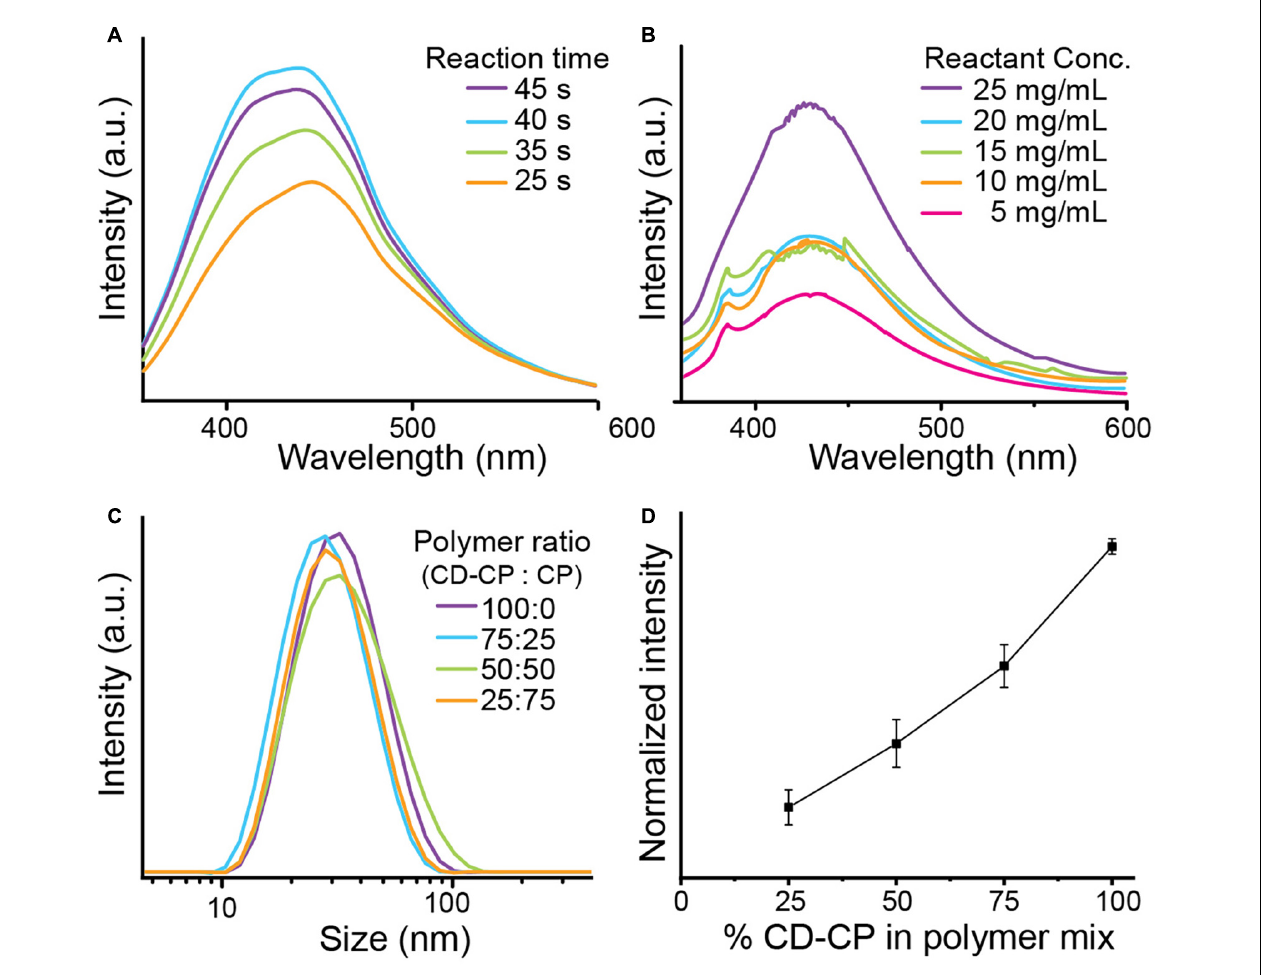
FIGURE 2 | Optimization of CNPCP synthesis parameters. (A) CD-CP reacted for various lengths of time, and (B) CD-CP reacted with varied concentration of glucosamine. (C) Hydrodynamic size distribution of CNPCP made with varying ratio of CD-CP and CP. (D) Maximum fluorescence intensity with increasing CD-CP content in polymer